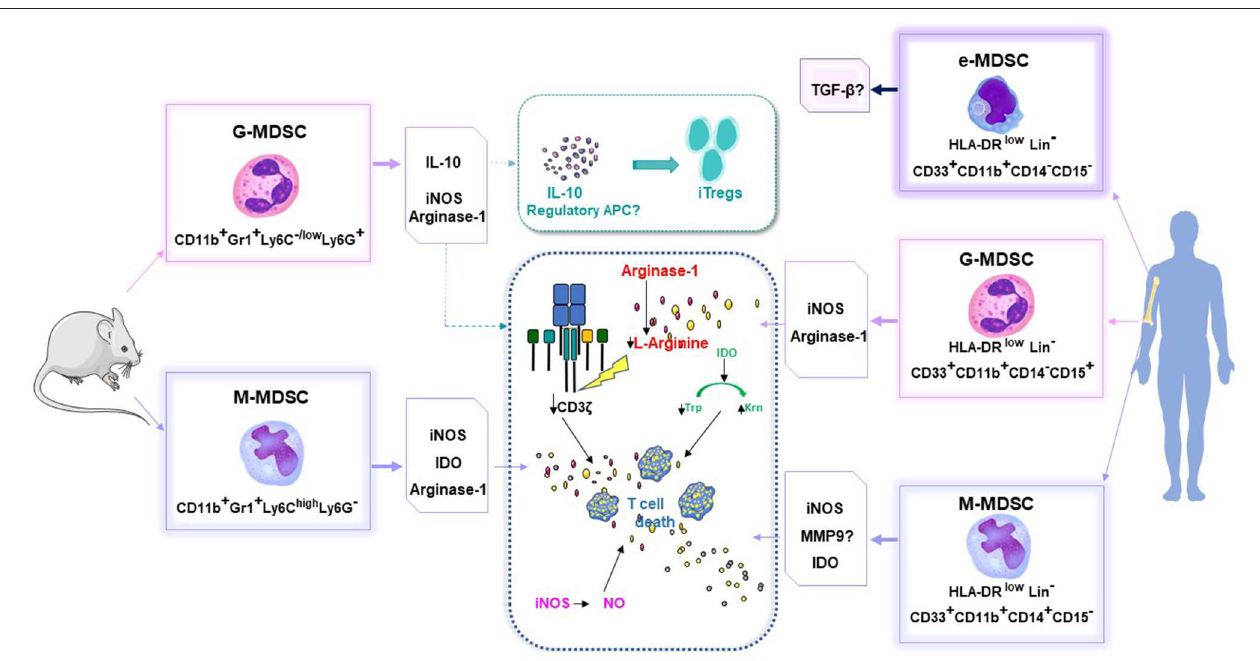
FIGURE 1 | MDSC phenotypes and their capacity to inhibit the proliferation of allogeneic T cells, in mice and humans. Arg-1, arginase; APC, antigen presenting cells; IDO, indoleamine 2,3-dioxygenase; Inos, inducible nitric oxide synthase; iTregs, induced T regulator cells; Krn, kynurenin; Lin, Lineage; MDSC, myeloid derived suppressive cells; M-MDSC, monocytic MDSC; G-MDSC, granulocytic MDSC; E or P-MDSC, early stage MDSC; MMP9, matrix metalloproteinase 9; TGF β , transforming growth factor beta; Trp,